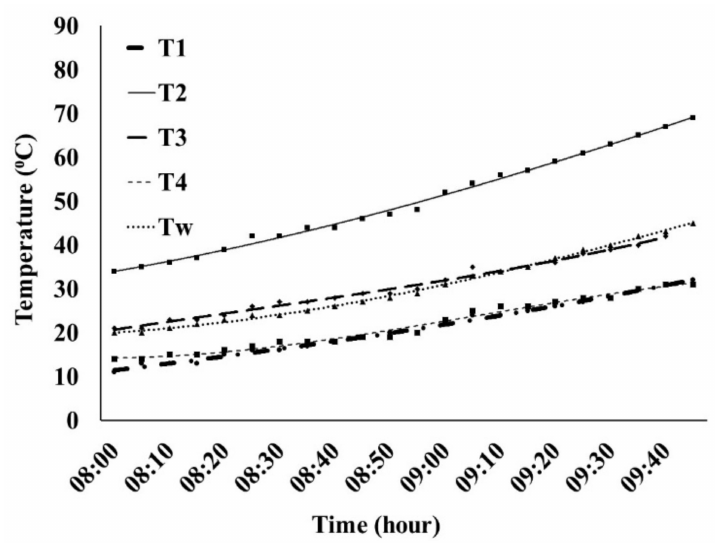
Figure 11. Variation of temperatures with time at different locations of SAHP